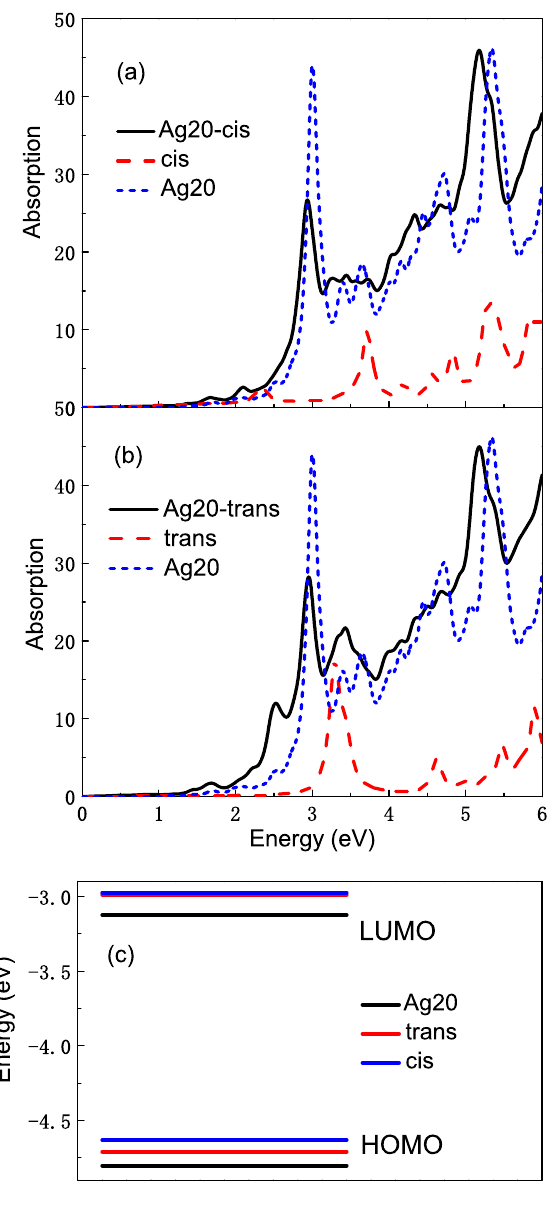
Figure 5. ( a ) The average absorption cross sections of the Ag20-cis azobenzene complex, isolated cis isomer and Ag20 cluster; ( b ) the average absorption cross sections of the Ag20-trans azobenzene complex, isolated trans isomer and Ag20 cluster; ( c ) the energy levels of HOMO and LUMO of Ag20, cis and trans